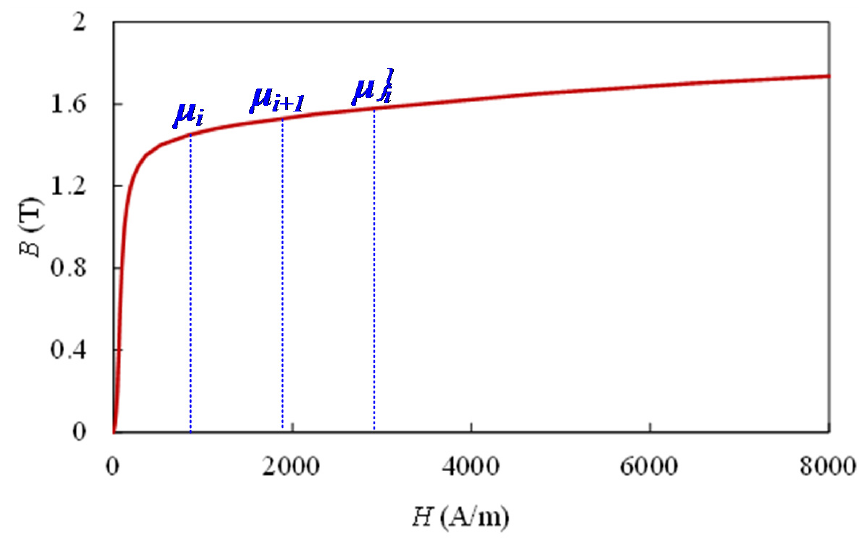
Figure 4. Demonstration of the convergence process according to the B–H curve.